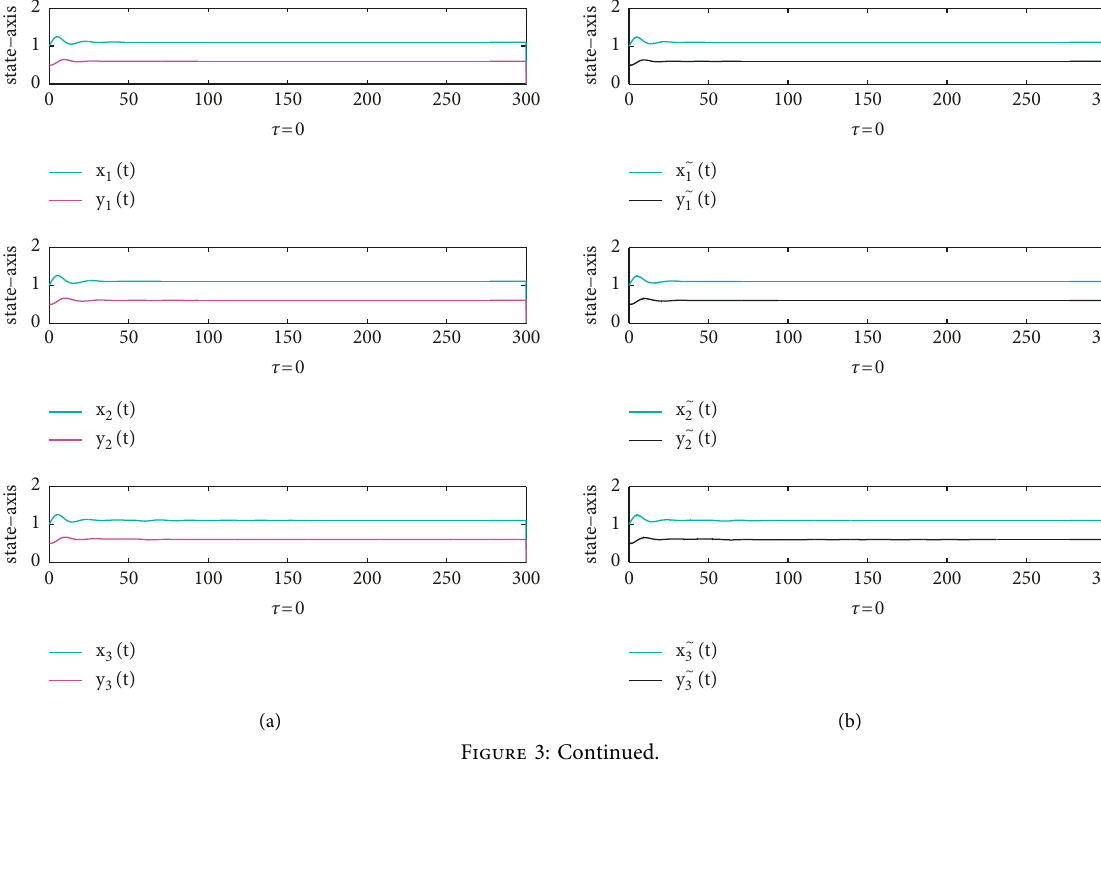
Figure 2: The effect of fear from predator on E ∗ � 2, respectively, where x and f 3 represent the intensities of predator species of (2) and (21), respectively. (a) The time series graph of prey of (2) and (21), respectively. (b) The time series graph of predator of (2) and (21) respectively. (c) The phase graph of prey and predator of (2) with f prey and predator of (21) with f